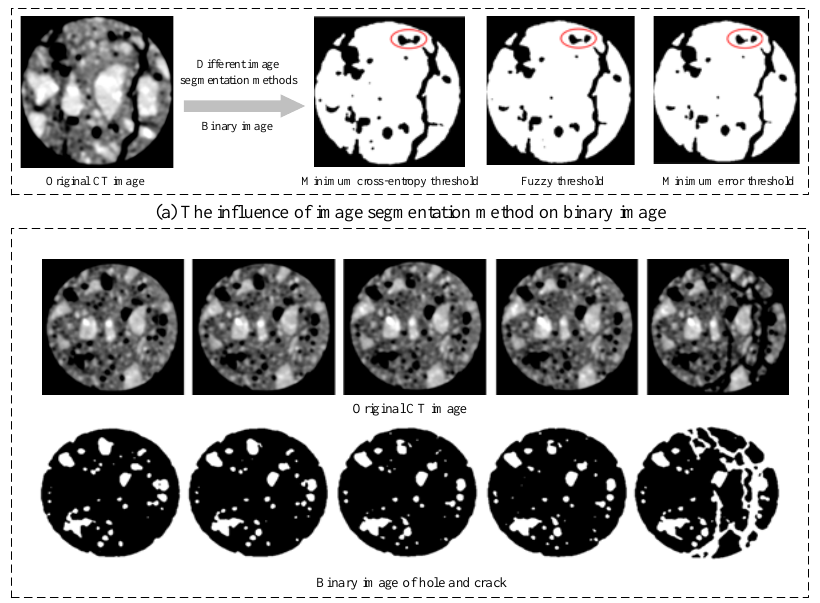
Figure 4. Determination of image segmentation method.